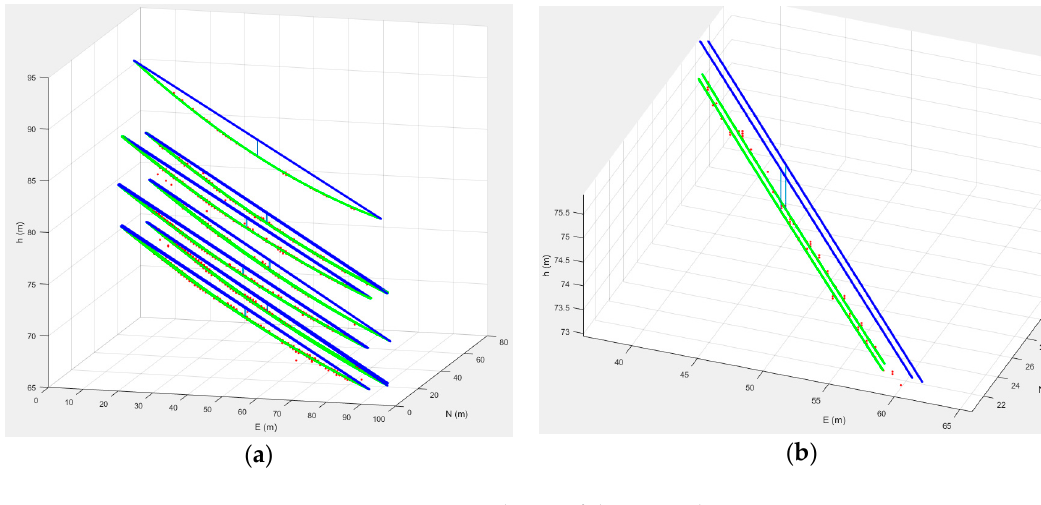
Figure 11. Interpolation of the power lines.